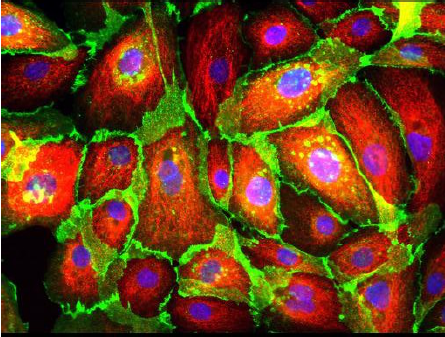
Fig. 2. Cryopreserved human mammary epithelial cells stained visualize the calcium-dependent cell-cell adhesion glycoprotein E-cadherin in green. Image by N. Prigozhina (2015) CIL:48102q